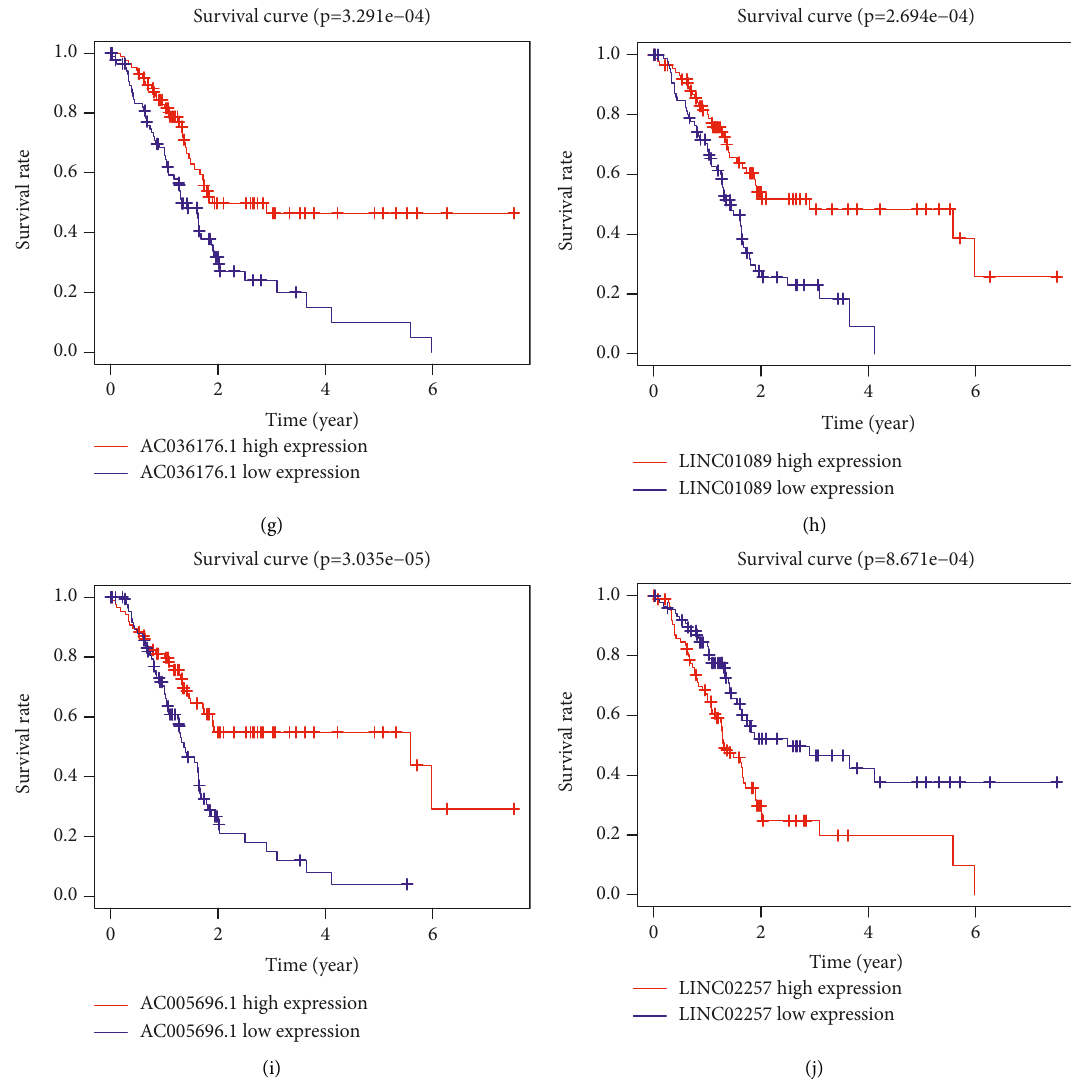
Figure 4: Kaplan–Meier survival curve of nine independently diagnosed lncRNAs in PC. Four lncRNAs were poor prognosis factors (AC245041.2 (B), AC036176.1 (G), LINC01089 (H), and LINC02257 (J)). Six lncRNAs were beneficial prognosis factors (FLVCR1-DT (A), AC006504.7 (C), AC125494.2 (D), AC012306.2 (E), ST20-AS1 (F), and AC005696.1